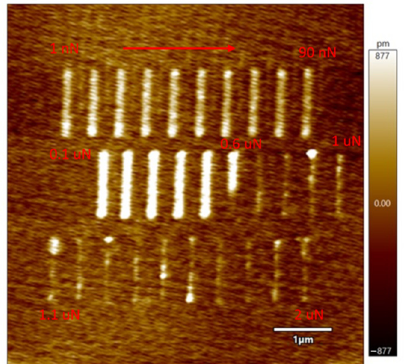
Figure 2. The lines scratched with different tip force: Top lines are the forces ranging from 1 nN to 90 nN with an increment of 10 nN. Middle lines are the forces ranging from 0.1 μ N to 1 μ N with an increment of 0.1 μ N. Bottom lines are the forces ranging from 1.1 μ N to 2 μ N with an increment of 0.1 μ N.